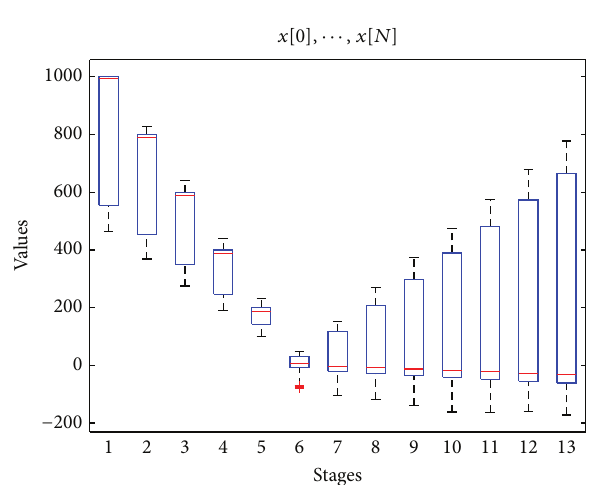
Figure 8: Case 2, box-plots for inventory levels when ordering by the median.